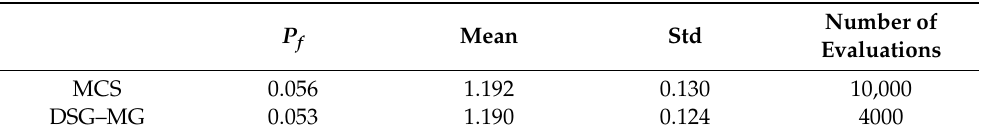
Table 3. Probabilistic results obtained by DSG–MG and